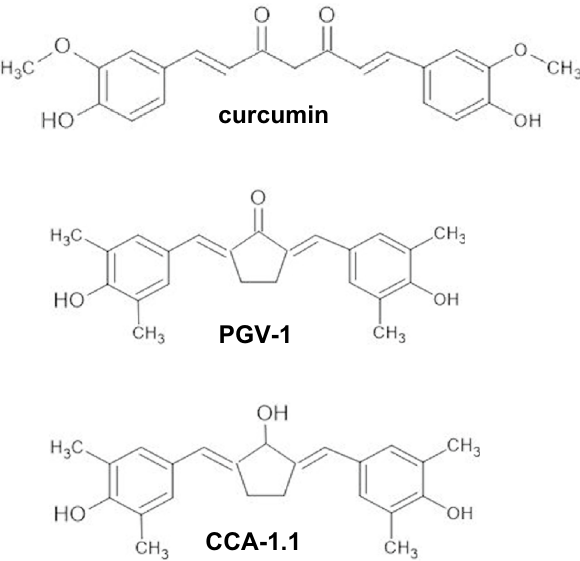
Figure 1. Chemical structures of curcumin, PGV-1, and